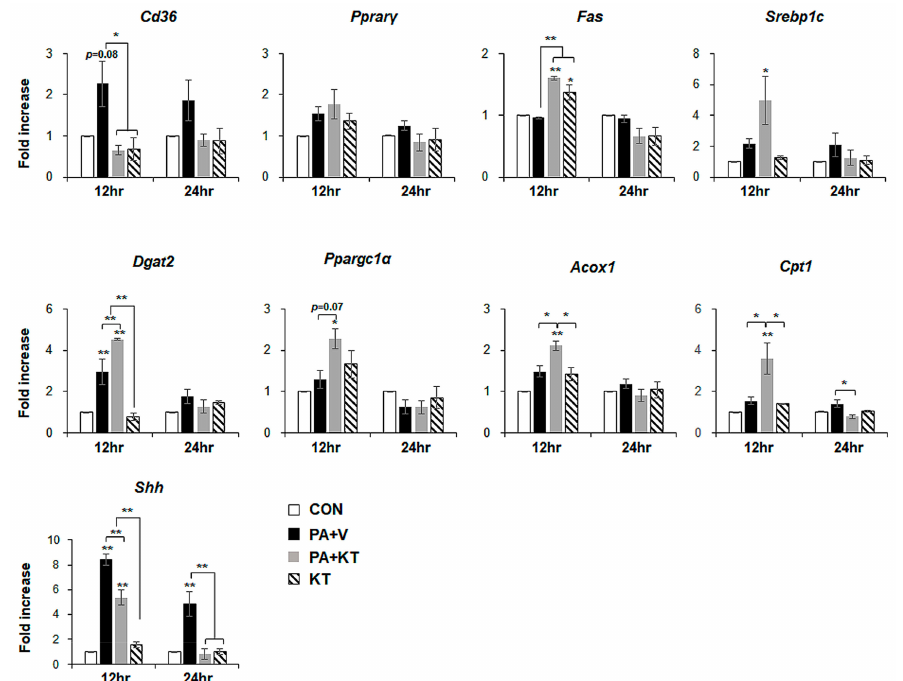
Figure 8. KT modulates lipid metabolism in hepatocytes damaged by PA. qRT-PCR analysis for Cd36, Ppar γ , Fas, Srebp1c, Dgat2, Ppargc1 α , Acox1, Cpt1, and Shh in CON, PA + V, PA + KT, and KT cell groups. The mean ± SEM results obtained from three repetitive experiments are graphed (* p < 0.05, ** p < 0.005 vs. CON